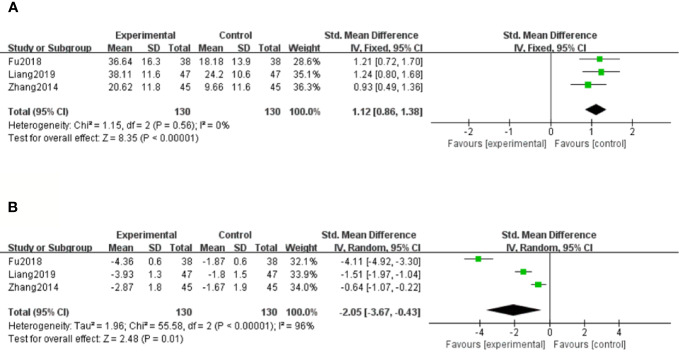
Forest plot for superoxide dismutase (SOD) between the treatment group and control group (A). Forest plot for malondialdehyde (MDA) between the treatment group and control group (B).